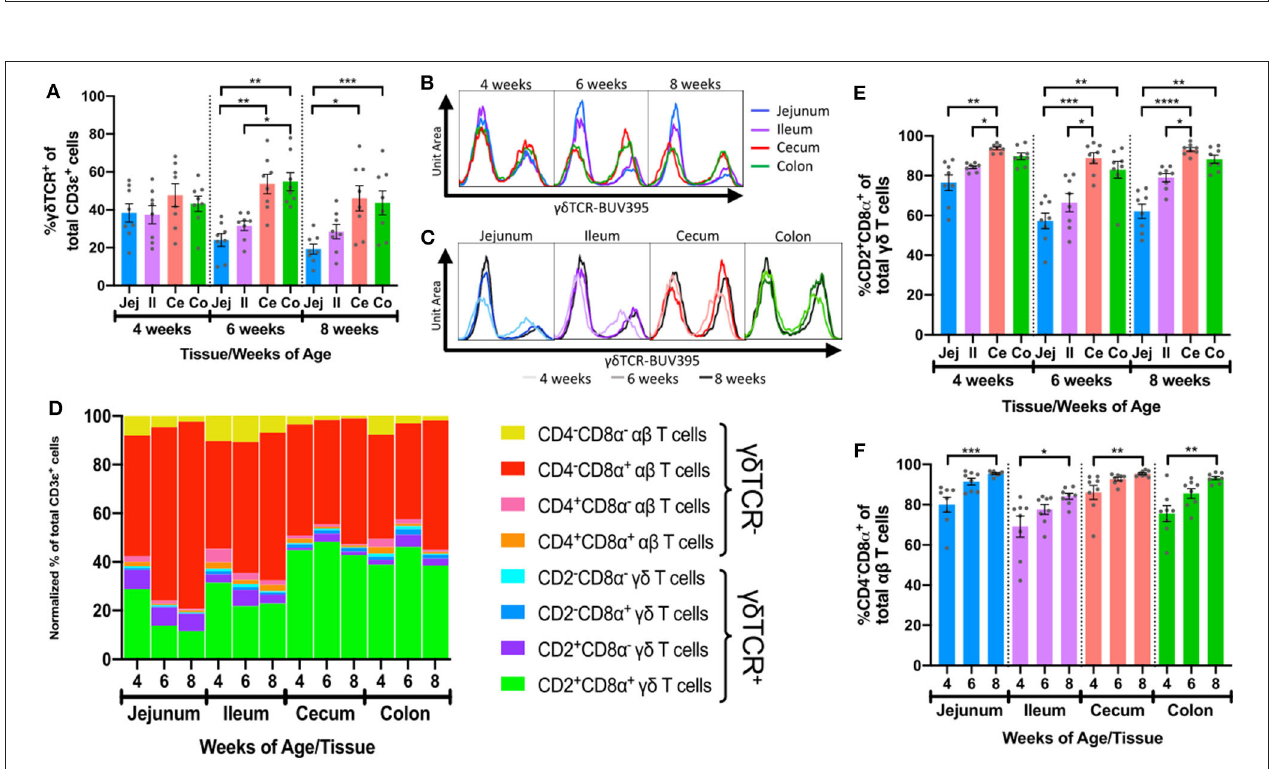
FIGURE 3 | defined by flow cytometry gating of αβ or γδ T cell populations and CD27 expression. Shorter distances between points represent greater similarities between samples. Centroids are plotted at the center of each 95% confidence ellipse for each sample type based on both intestinal tissue and pig age during sample collection. Centroids from each particular timepoint of a single tissue are sequentially connected chronologically. Point, ellipse, and line color is tissue-specific, while centroid shape is age-specific. (C,D) Visualization of pairwise PERMANOVA test results comparing IET compositions from samples between timepoints within a tissue (C) or between tissues within a single timepoint (D) . Relationships between variables are represented by connecting lines. Magnitudes of the F model statistics demonstrate the influence of a comparison and are represented by the width of the lines, while color of the line represents statistical significance (red = significant; black = not significant). P -values were corrected for multiple comparisons using the FDR method considering all tests displayed here, p < 0.05 were considered significant. Samples were taken from four animals per timepoint in each of two separate experiments ( n = 8 per timepoint; n = 24 total).